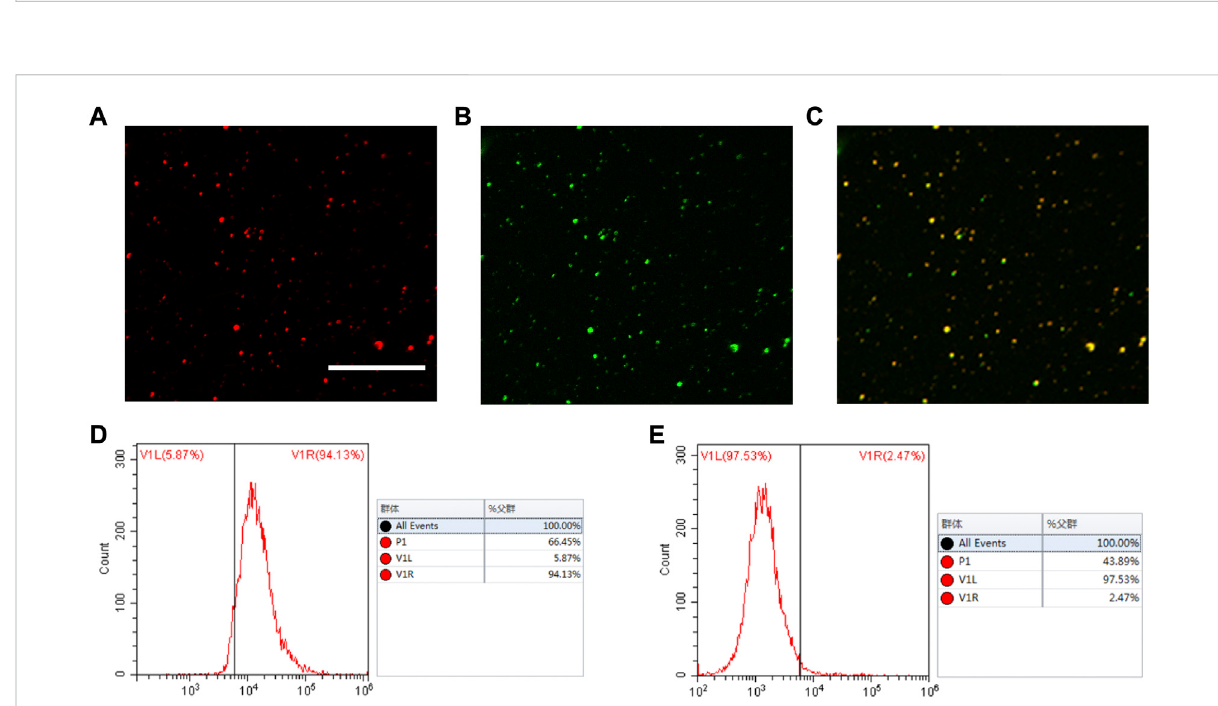
FIGURE 3 CLSM and FCM images of the cRGD-PLGA-Fe 3 O 4 -PFOB NPs. (A) Nile red (×400; Scale: 50 μ m). (B) FITC. (C) Merge. (D) FCM image of PLGA-